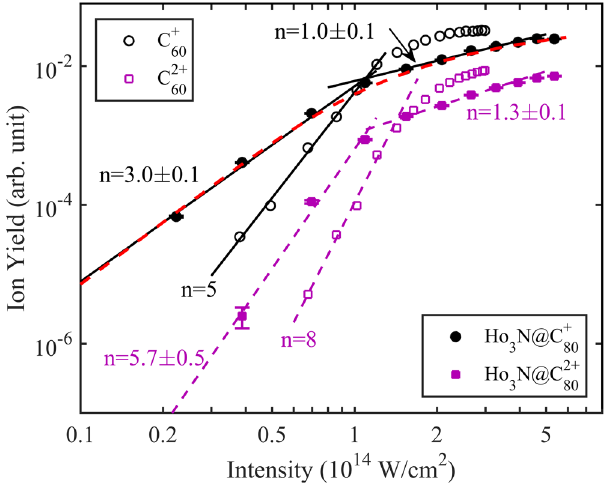
Figure 2. Comparison of the ion yield dependence on peak intensity for the ionization of Ho 3 N@C 80q + (q = 1, 2) (filled symbols) and C 60 q + (q = 1, 2) (open symbols). The Ho 3 N@C 80 q + results are extracted from data in Fig. 1 and the yields of Ho 3 N@C 80 with a charge q = 1 is multiplied by 5. The C 60 data are from ref. 40 and the C 60 + yield was multiplied by 2 for clarity.